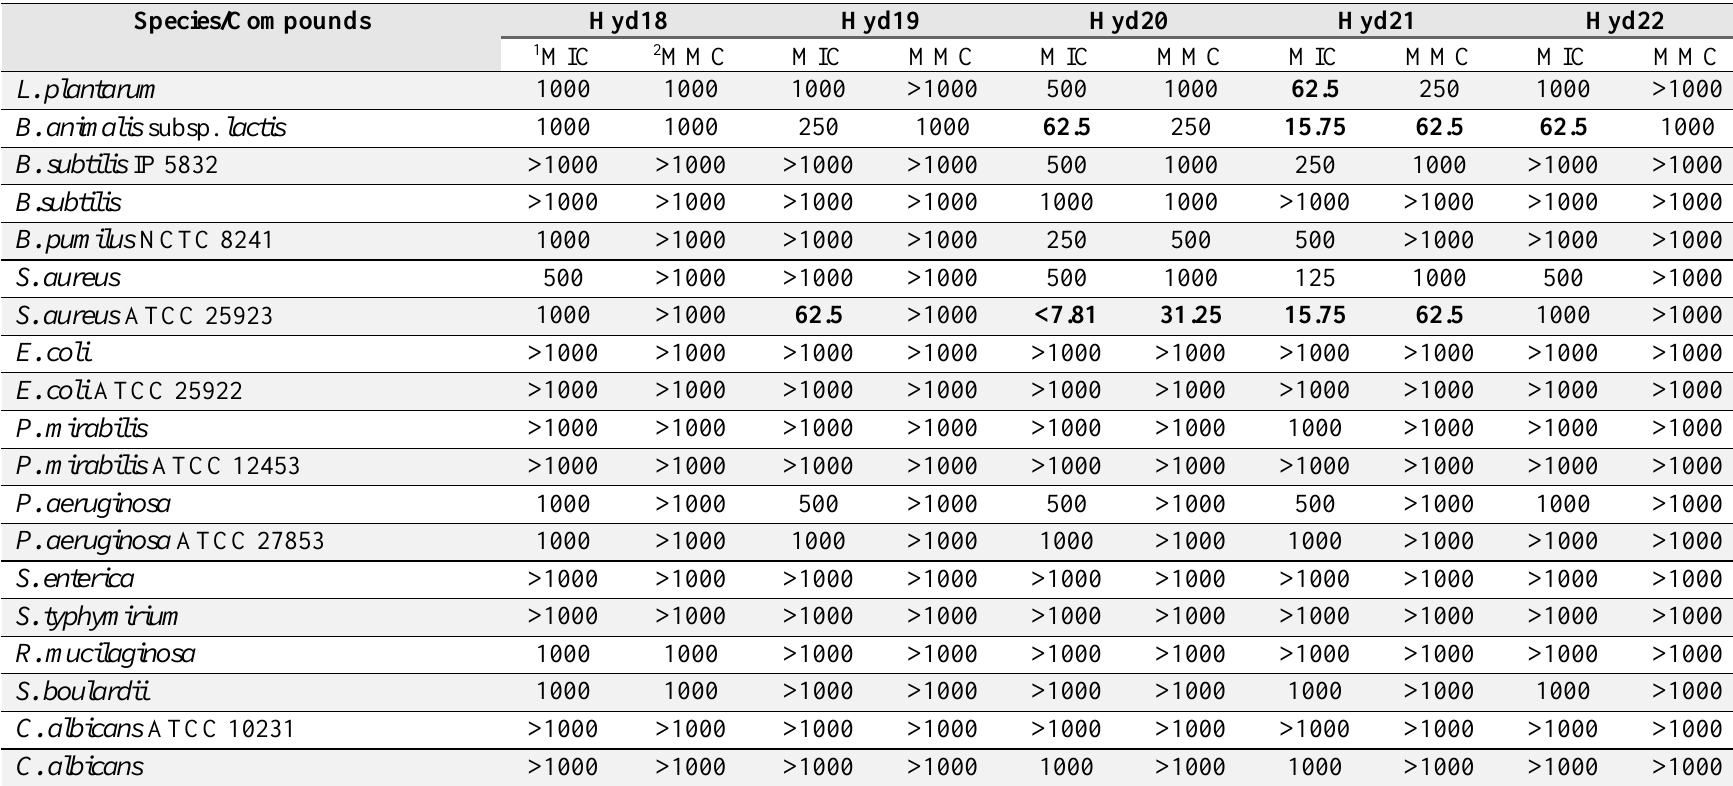
Table 5. Antimicrobial activity of bicyclic and tricyclic phenylseleno hydantoin